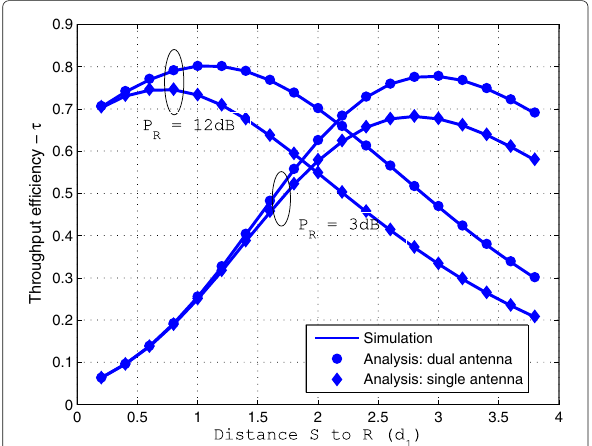
the loop-back noise is eliminated. When SI factor ranges from − 20 to − 5 dB, the performance of TSAC scheme is superior to the existing protocols, but when SI parame- ters are greater than − 5 dB, the optimal throughput of the proposed protocol in [28] is a prime candidate. Thanks to the EH protocol proposed in [28], the loop interference at relay is reused for self-energy recycling. As a result, part of the energy (loop energy) is used for information transmission by the relay and it improves the scheme’s performance. According to Fig. 10, the throughput changes dramat- ically when we move the relay node in several positions between the source and destination node. The results are then obtained by setting d 1 = 0.2 → 3.8, d 2 = 4 − d 1 .